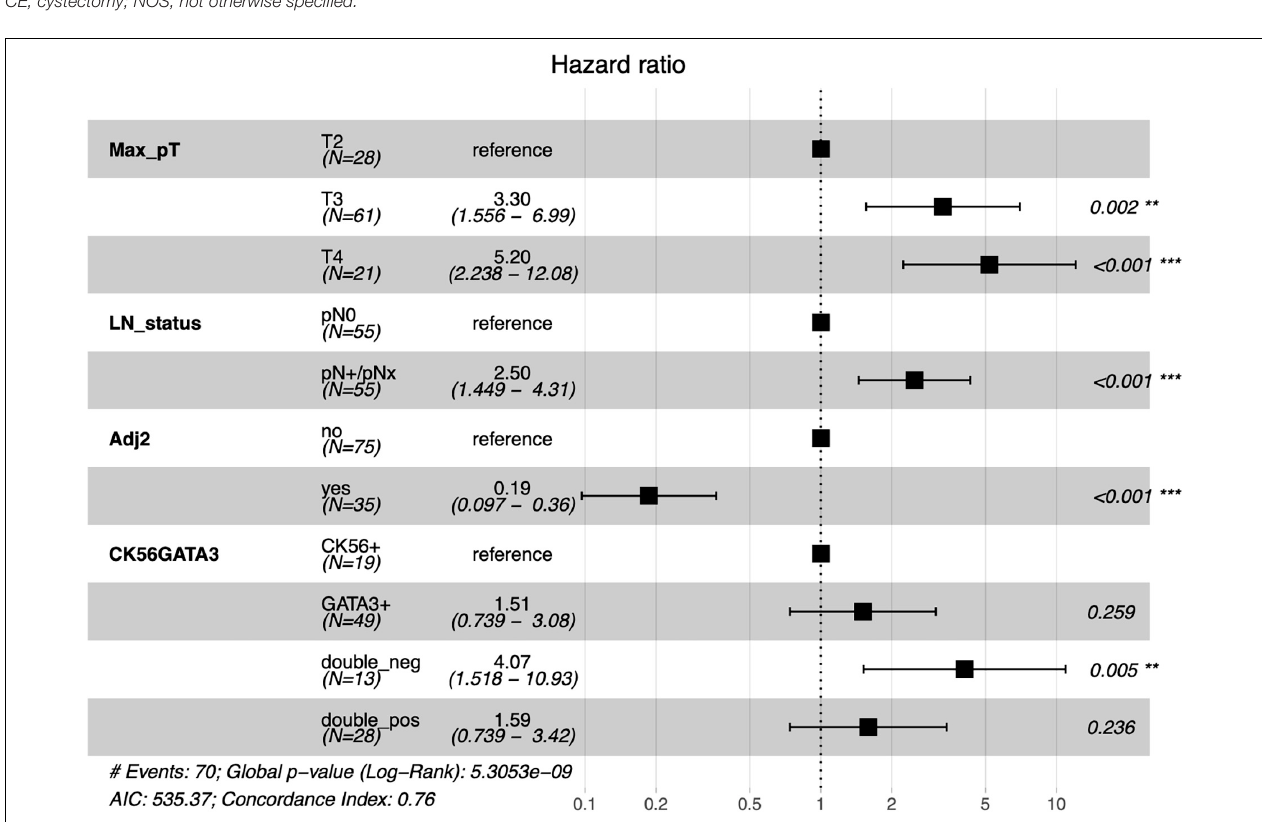
FIGURE 3 | Multivariate cox-regression model for OS adjusting for tumor and LN stage, adjuvant chemotherapy, and the IHC-markers CK5/6 and GATA3. Number of events: 70; Global p -value (Log Rank): 5.3053e-09. LN, lymph node; Adj2, at least two cycles of adjuvant chemotherapy. ∗∗ p < 0.05; ∗∗∗ p < 0.001.